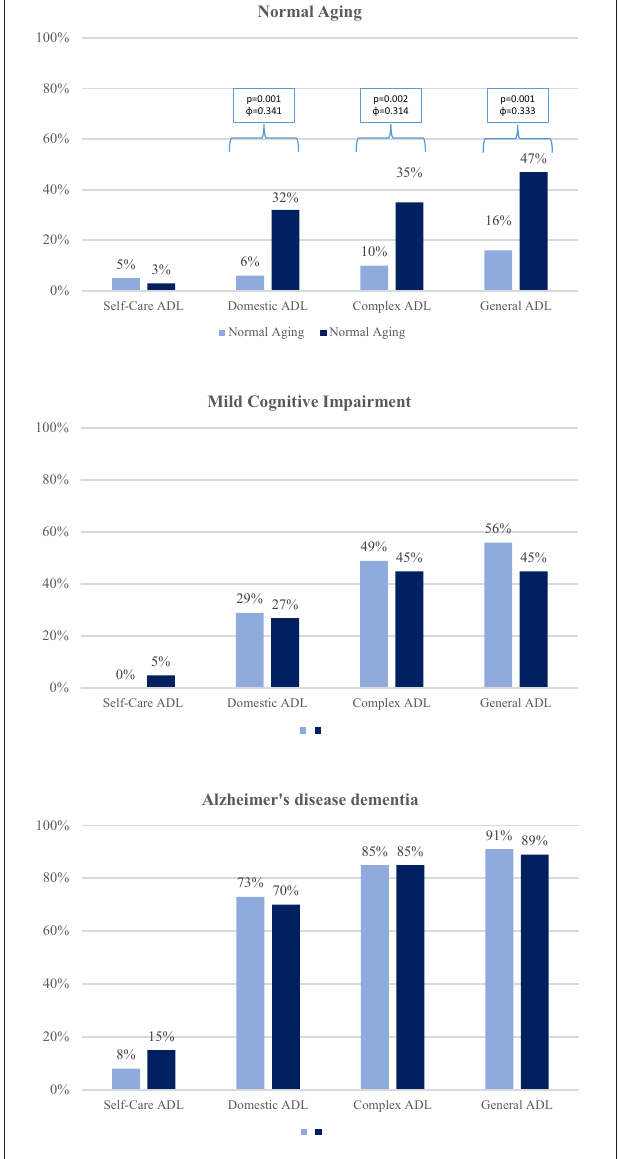
FIGURE 3 | Associations between the frequency deficits in different types of ADL and the presence of clinically significant symptoms of depression in each group. We found significant differences in frequency of impairment (partial or complete) of at least one ADL and the presence of clinically significant symptoms of depression only in the NA group. Impairment in instrumental-domestic ADL ( p = 0.001 , ϕ = 0.341), instrumental-complex ADL ( p = 0.002 , ϕ = 0.314), and ADL general ( p = 0.001 , ϕ = 0.333) were more frequent in participants with clinically significant depressive Symptoms. The association between depression and ADL was found in MCI or AD participants (effect sizes ranged from 0.004 to 0.185).